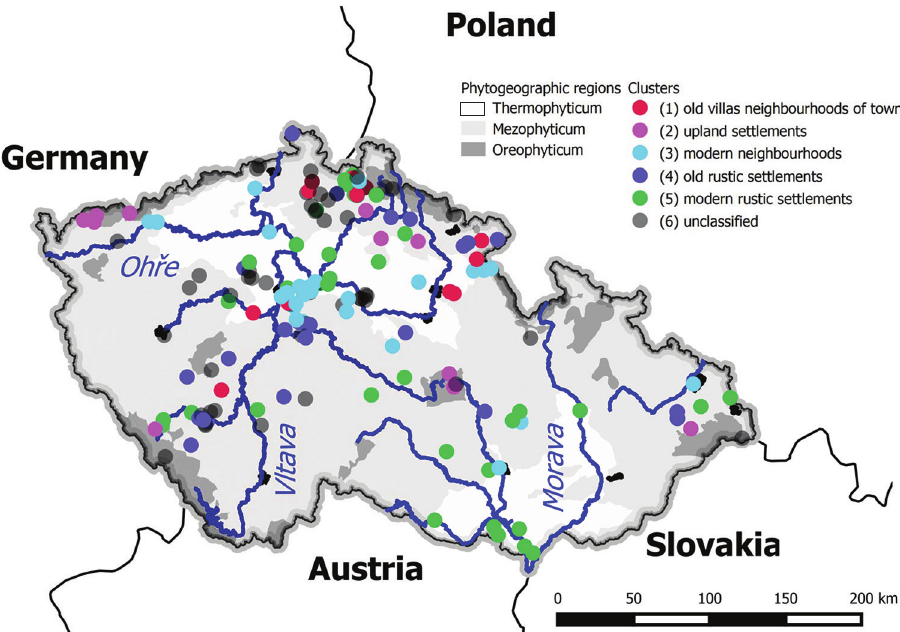
Figure 1. Map of sample sites in the Czech Republic. Phytogeographic regions, reflecting the climatic con- ditions, are indicated by three shades of grey. Thermophyticum includes warm areas with a thermophilous flora and vegetation. Mesophyticum harbours flora and vegetation typical of the central European temper- ate zone. Oreophyticum is a cold region with mountain flora and vegetation corresponding to forests of the boreal zone, with smaller areas above the timberline similar to habitats in the arctic zone (see Kaplan